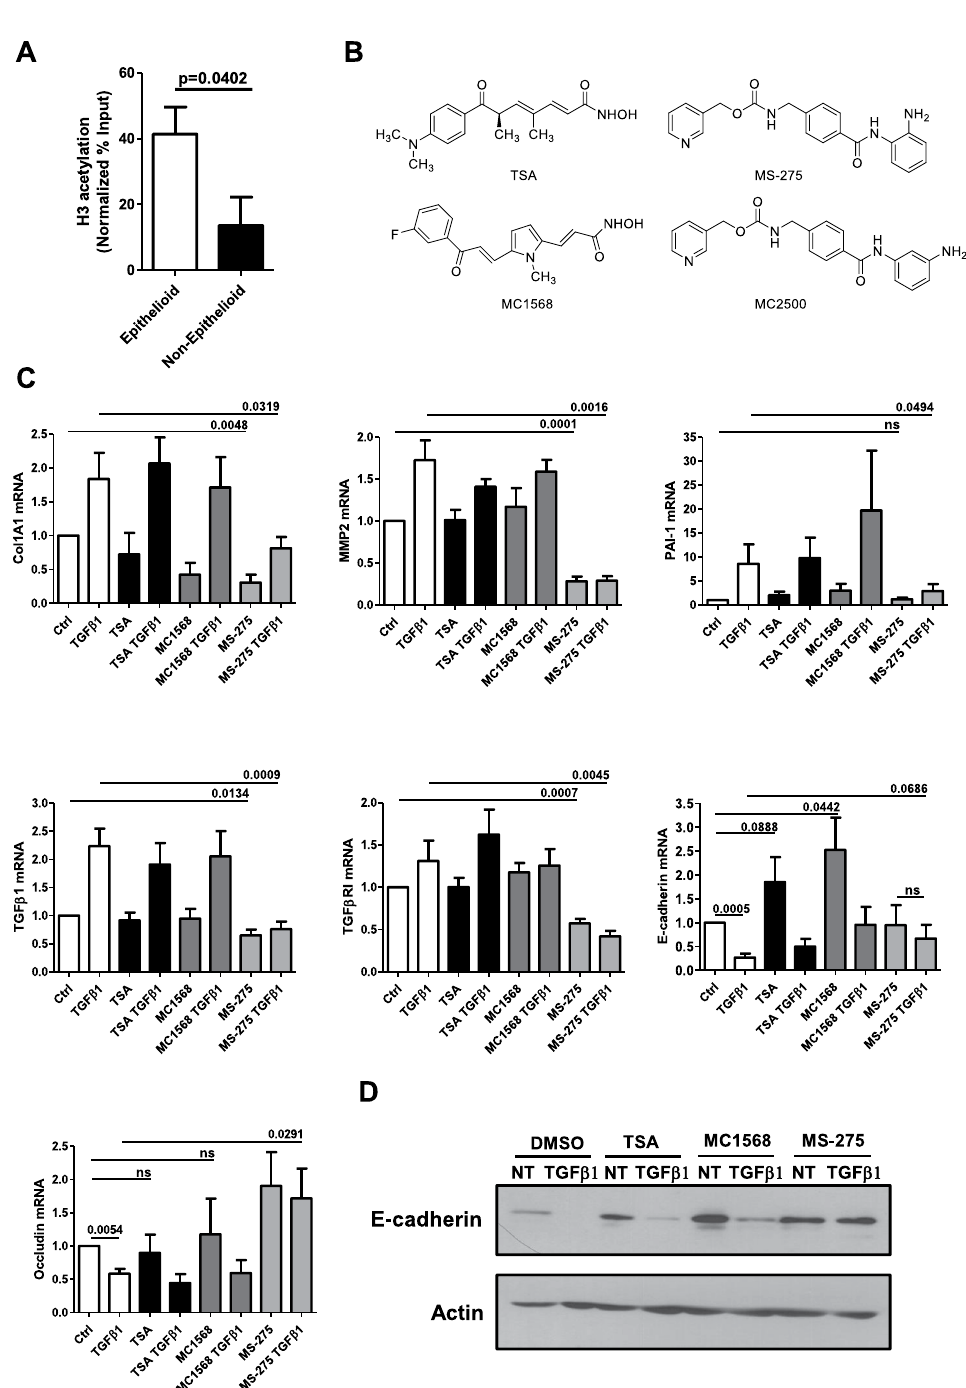
Figure 1. Effect of Class I and Class II HDAC inhibition on epithelial and mesenchymal markers expression in MCs derived from peritoneal effluent of PD patients. ( A ) qPCR analysis of ChIP assays with anti-acH3 antibody and, as controls, normal rabbit IgG on chromatin from epithelial-like (epithelioid) MCs (left) and mesenchymal-like (non-epithelioid) MCs (right). Data show the enrichment of H3 acetylation on human E-cadherin promoter. Values derived from three independent experiments are normalized respect to the IP efficiency (evaluated through GAPDH promoter amplification). Data are reported as means ± SEM and expressed as ((IP-IgG) %Input). ( B ) Chemical structures of HDAC inhibitors used in this study. ( C ) MCs were treated with DMSO vehicle (Ctrl) or with TSA (TSA) (30 nM), MC1568 (10 μ M), MS-275 (250 nM) for 72 h; samples were also either left untreated or were treated with TGF β 1 (2 ng/ml) for the last 24 h. Expression of Col1A1, MMP2, PAI-1, TGF β 1, TGF β RI, E-cadherin and Occludin was evaluated on total RNA by qRT-PCR. Bars represent means ± SEM of 5 experiments (for Col1A1 and Occludin n = 4). p-values are reported in the graphs. ( D ) Representative Western blot experiment of 5 performed showing expression of E-cadherin from cell lysates of MCs treated as above. Actin was used as a loading control. P < 0.05 was considered